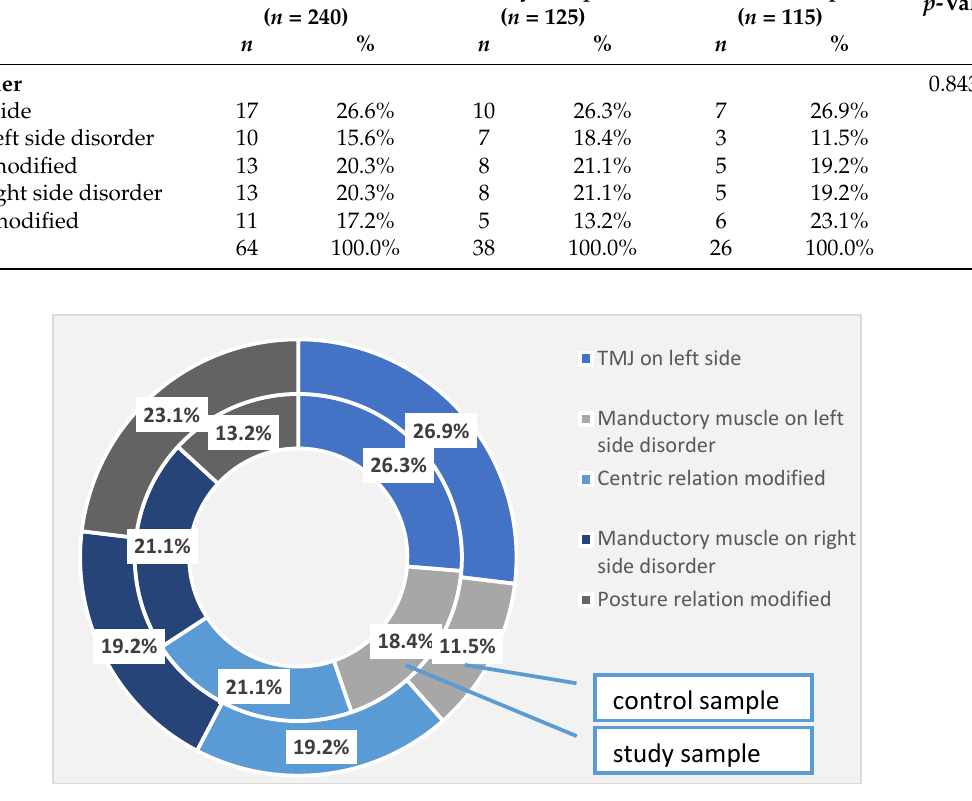
Figure 1. TMJ disorders identified at the investigated patients (the total sample).